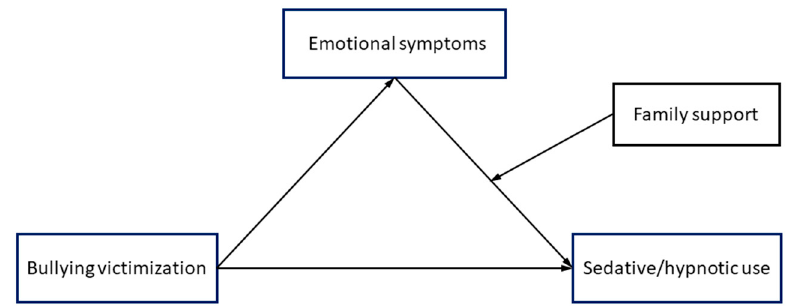
Figure 1. Conceptual model of the moderated mediation.